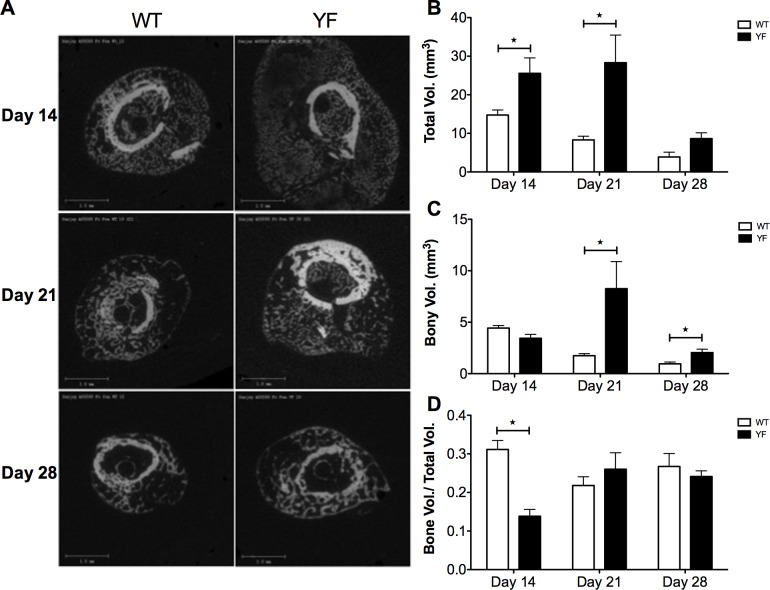
MicroCT measurements showed increased total callus and bony volume in mice lacking Cbl-PI3K interaction.A. Fractured femora were harvested from WT and YF mice at 14, 21 and 28 days post-fracture, and scanned by MicroCT. Bar charts show B. Total callus volume C. Bony callus volume D. Ratio of bony over total callus volume. n = 5–6, *p<0.05 vs. WT.